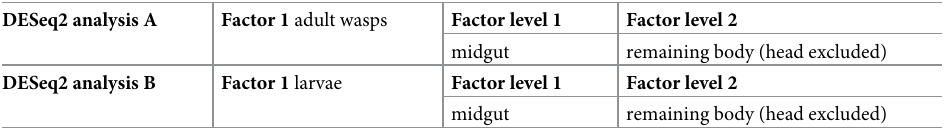
Table 2. DESeq2 design specified for DGE analysis in this study. DESeq2 analysis A Factor 1 adult wasps Factor level 1 Factor level 2 midgut remaining body (head excluded) DESeq2 analysis B Factor 1 larvae Factor level 1 Factor level 2 midgut remaining body (head excluded) Factor 1 of the DESeq2 analysis A “adult wasps” comprises a total of twelve transcriptome samples i.e., six “midgut” and six “remaining body” individual samples. Factor 1 of DESeq2 analysis B “larvae” comprises a total of six transcriptome samples i.e., three “midgut” and three “remaining body” individual